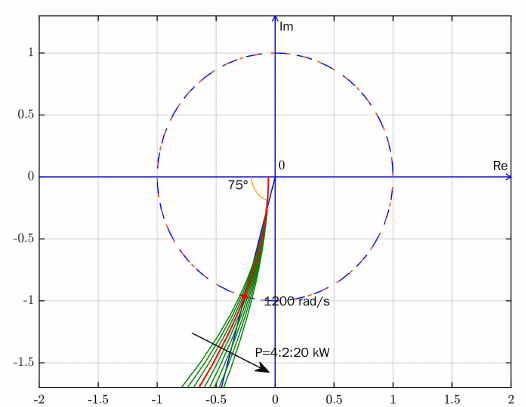
Figure 9. Nyquist plot of the open-loop frequency response L ( ω , T s ) = C i ( ω , T s ) G vi ( ω , T s ) with the nominal power load value (red) and under load variation from 4 to 20 kW (green).